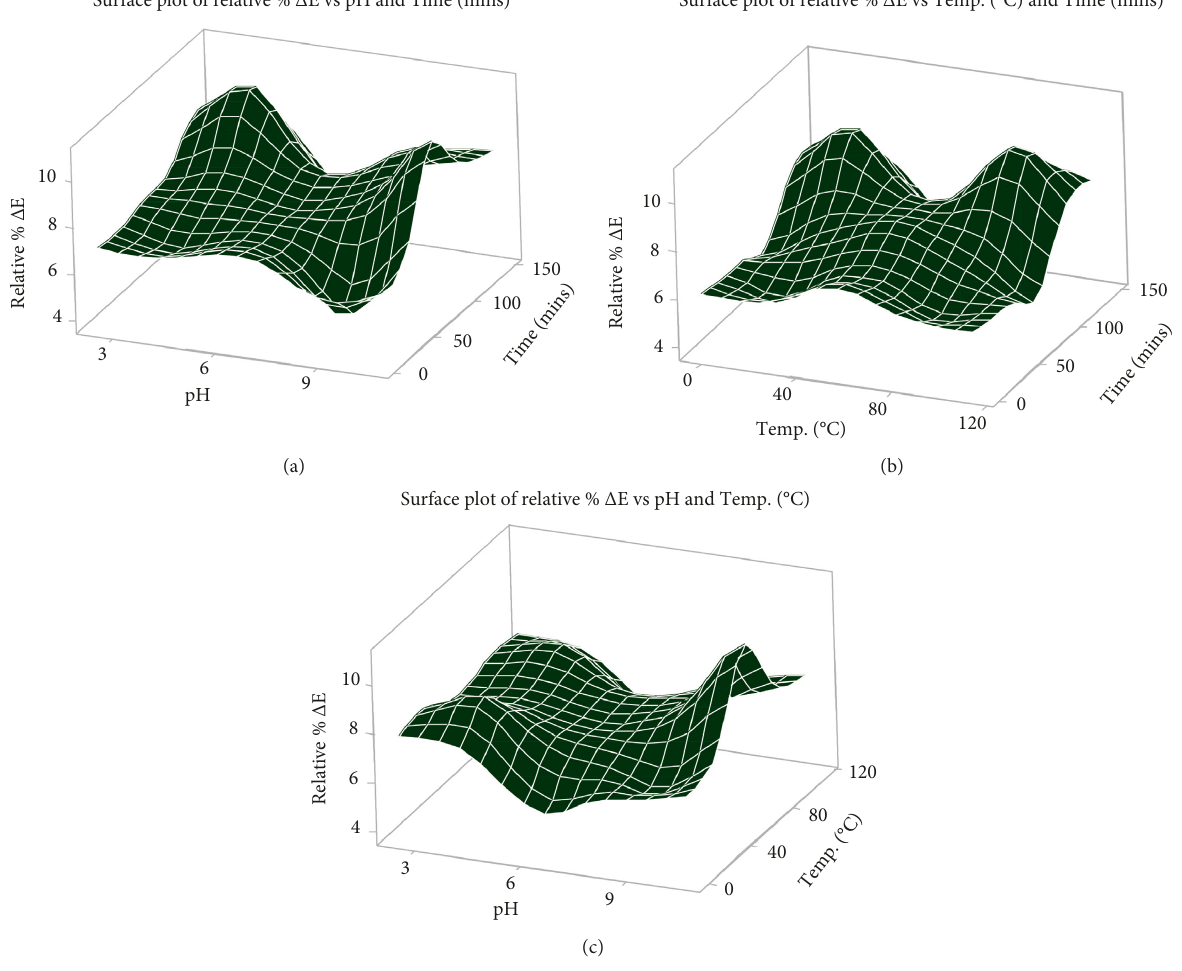
Figure 2: RSM for dyeing of the cotton substrate using B vulgaris peels and pomace extract. (a) Correlational effect of pH and time on relative % Δ E . (b) Correlational effect of temperature and time on relative % Δ E . (c) Correlational effect of pH and temperature on relative % Δ E